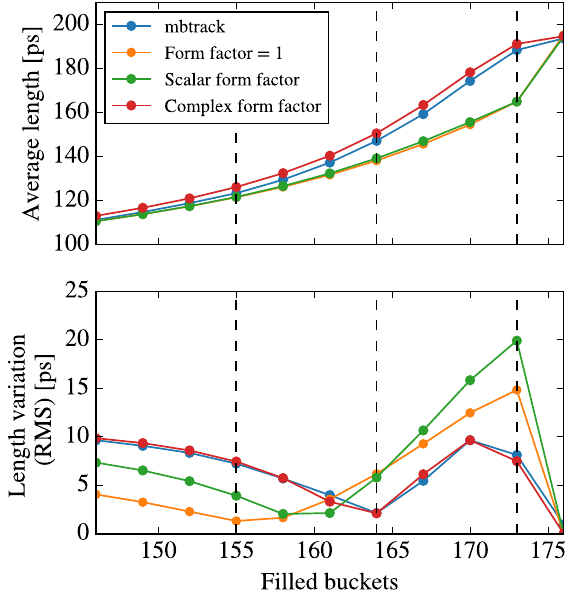
FIG. 7. Average (top) and variation (bottom) of the bunch length as a function of number of filled buckets for MBTRACK and the matrix formulation for different cases of the form factor. The results for 173, 164, and 155 bunches in the fill pattern are indicated (black dashed). The natural bunch length for the simulated case is 40